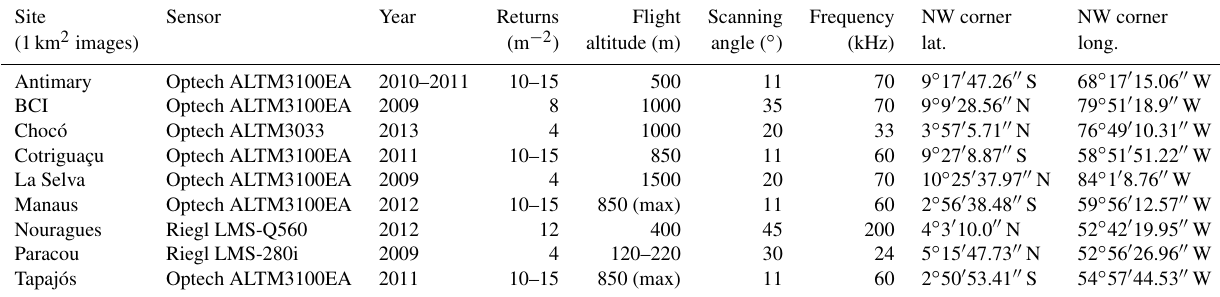
Table 2. Information on lidar data and locations of the nine research sites.